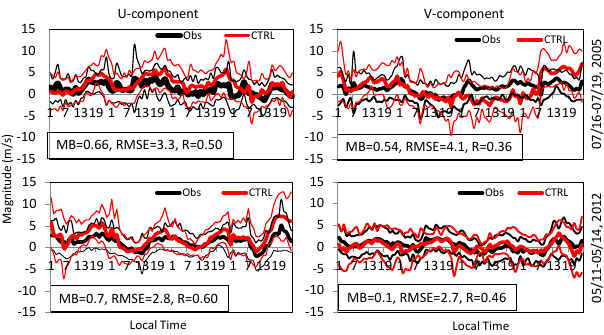
Figure 2. Surface wind comparisons between simulations (bold- red) and observations (bold black). There are 20 sites in total, in- cluding those in CA and AZ with locations shown in Fig. 1b as circles. The variation ranges of simulation and observation are cor- respondingly labeled by thin-red-line and thin-black-line, respec- tively. Mean Biases (MB), RMSE and correlation coefficient ( R ) are labeled also. CTRL represents WRF-Chem control